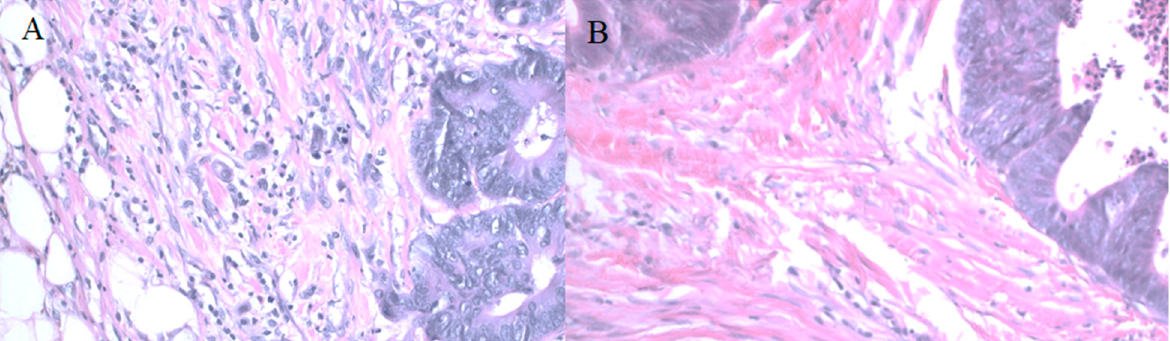
Figure 5. Budding assessment (200× magnification, Olympus BX 51 microscope, Olympus Life Science, Olympus manufacturer, Tokyo, Japan), (A) high budding tumor (6 buds in the camera field of view (FOV), more than 10 buds in full microscope FOV), ( B ) Low budding tumor, 1 bud in FOV.